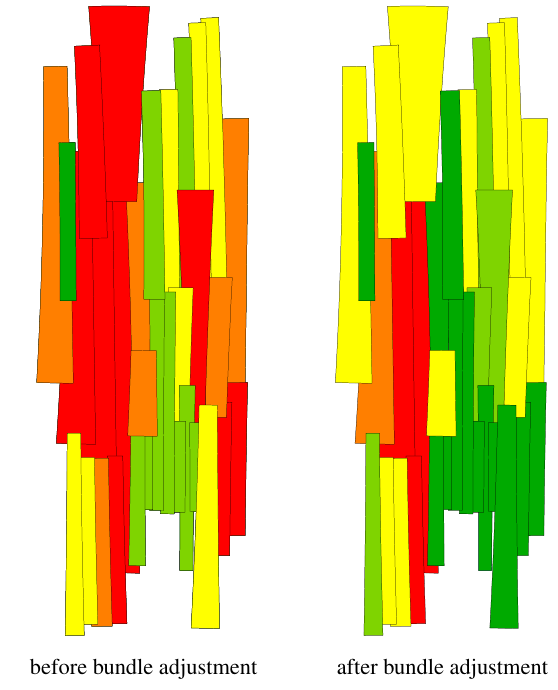
Figure 6: Mean intersection error of tie points per